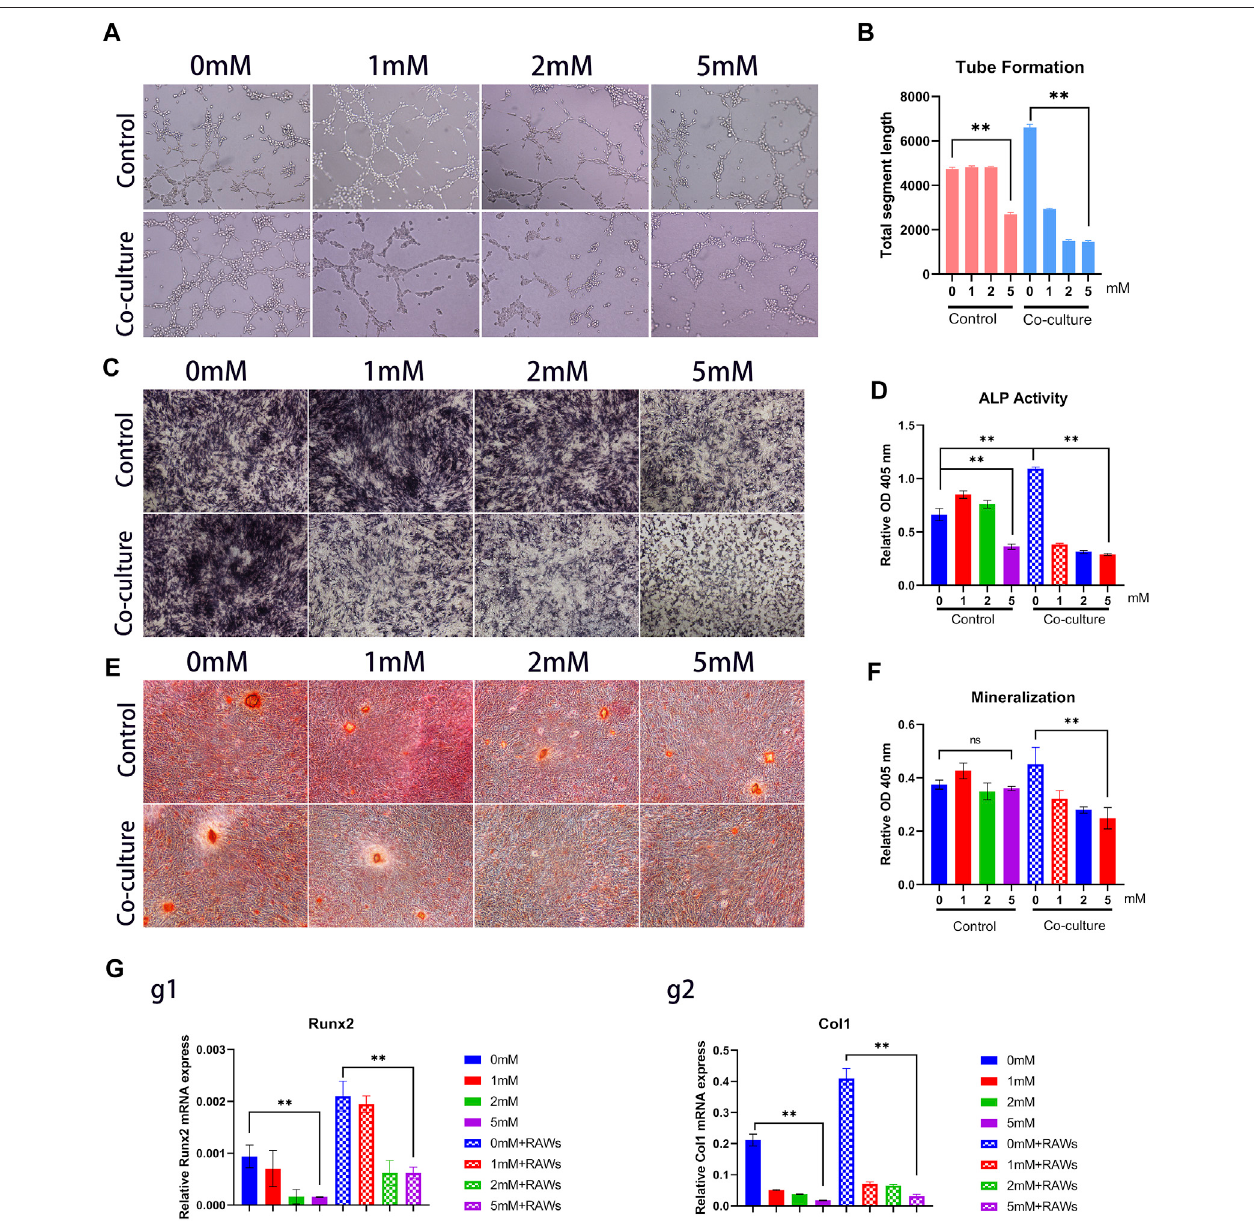
FIGURE6| Fluoride-inducedmacrophagesinhibitMSCsandHUVECsmigration. (A) InaTranswellculturesystem,thelowerchamberswereaddedwithamedium that cultured RAW or RAW + fl uoride for 24 h. C3H10T1/2 cells were added to the upper chambers, and the cells were cultured. Twenty-four hours after that, the membranes were stained with crystal violet for the enumeration of migrated MSCs. (B) Representative microscopic images show the migration of MSCs in the membranes. The violet color indicates migrated cells (×50, scale bar 400 μ m). (C) Cumulative data show migrated MSCs (average number of 3 different microscopic fi elds). (D,E) Wound healing assays of C3H10T1/2 and HUVECs showed signi fi cantly increased migratory abilities in co-cultured with fl uoride treatment. (F,G) Relative rate of % of 0 h gap area. The data are shown as mean ± SD for three separate experiments. * p < 0.05, ** p <